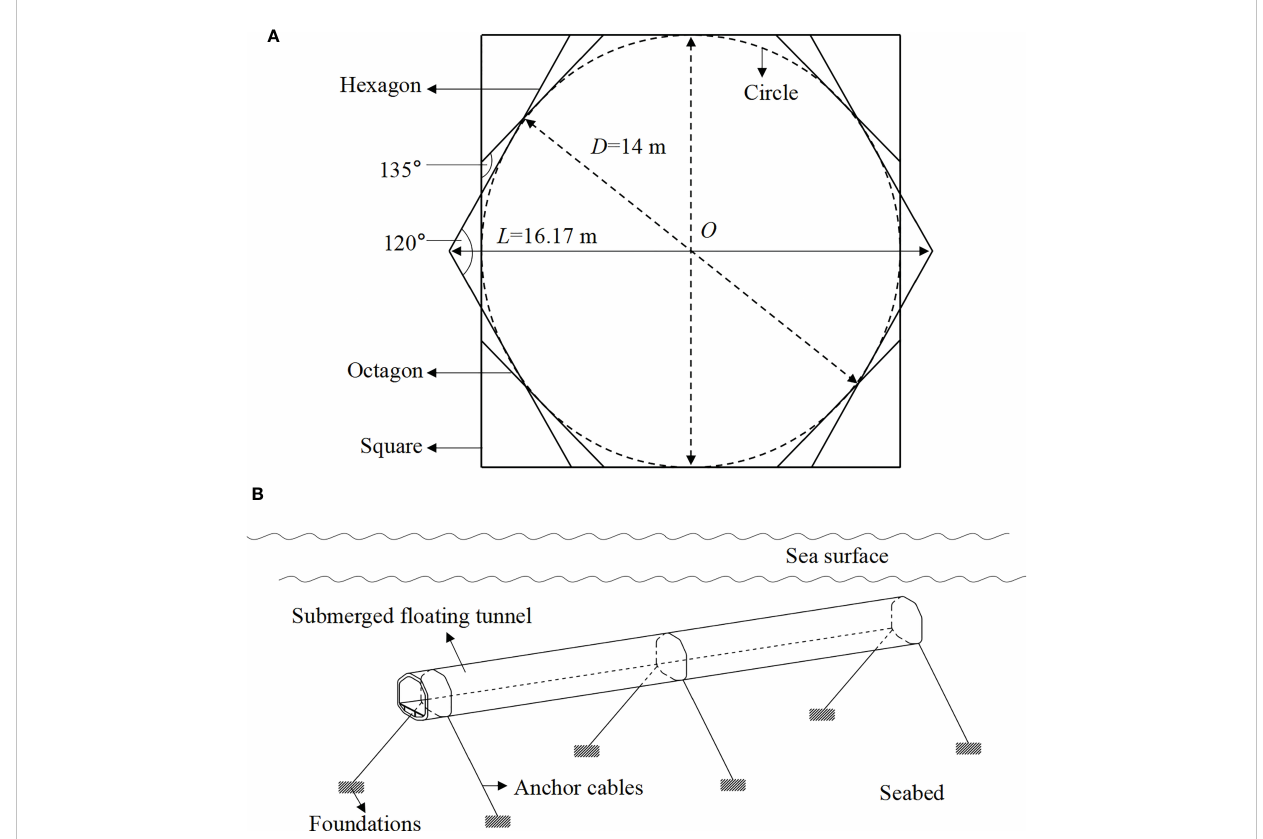
FIGURE 2 Cross-section types of polygonal cross-sections (square, hexagon, and octagon) (A) and 3-dimensional views (an example of the submerged fl oating tunnel with an octagon cross-section) tunnels discussed in this study (B)